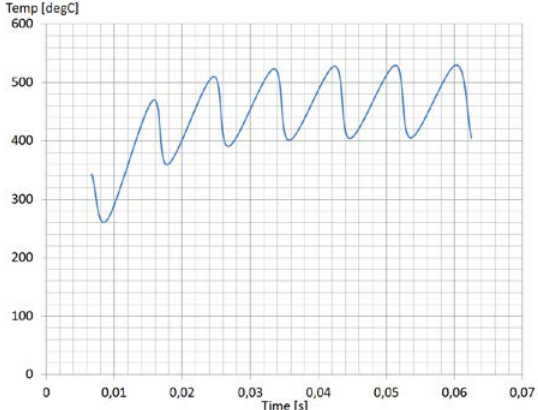
Fig. 10. Simulated signal course from instantaneous temperature sensor